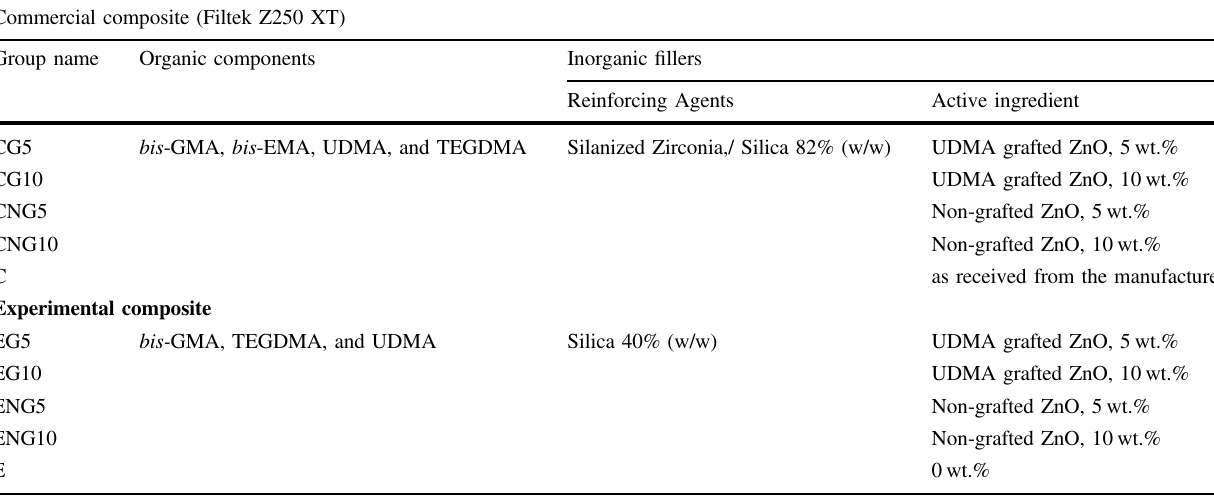
Table 1 Composition and groups of composite used in the current study Commercial composite (Filtek Z250